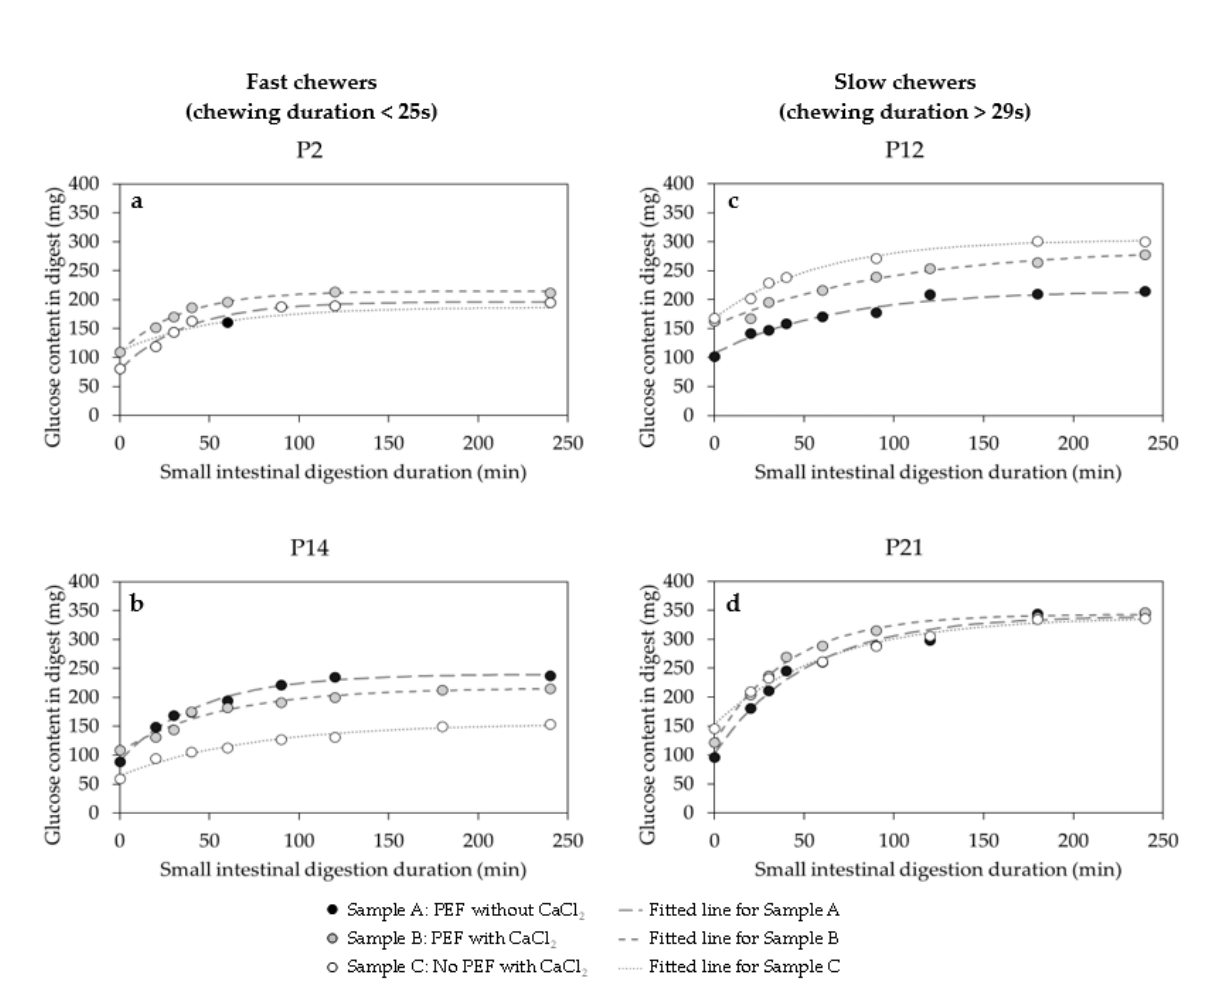
Figure 9. Kinetics of in vitro starch digestion (small intestinal phase) of in vivo masticated oral boluses of three cooked black bean samples (A: PEF and thermally processed without CaCl 2 addition; B: PEF and thermally processed with CaCl 2 addition; and C: No PEF, thermally processed with CaCl 2 ) from selected fast ( a , b ) and slow ( c , d ) chewers. Experimental data are represented by circle markers and the predicted values using fractional conversion model (Equation (6)) are shown in lines.